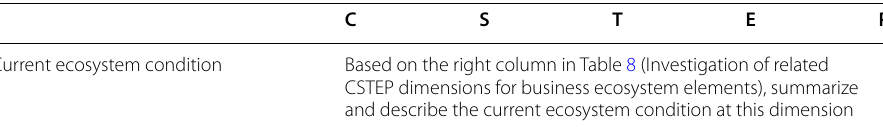
Table 13 Identification of the current ecosystem